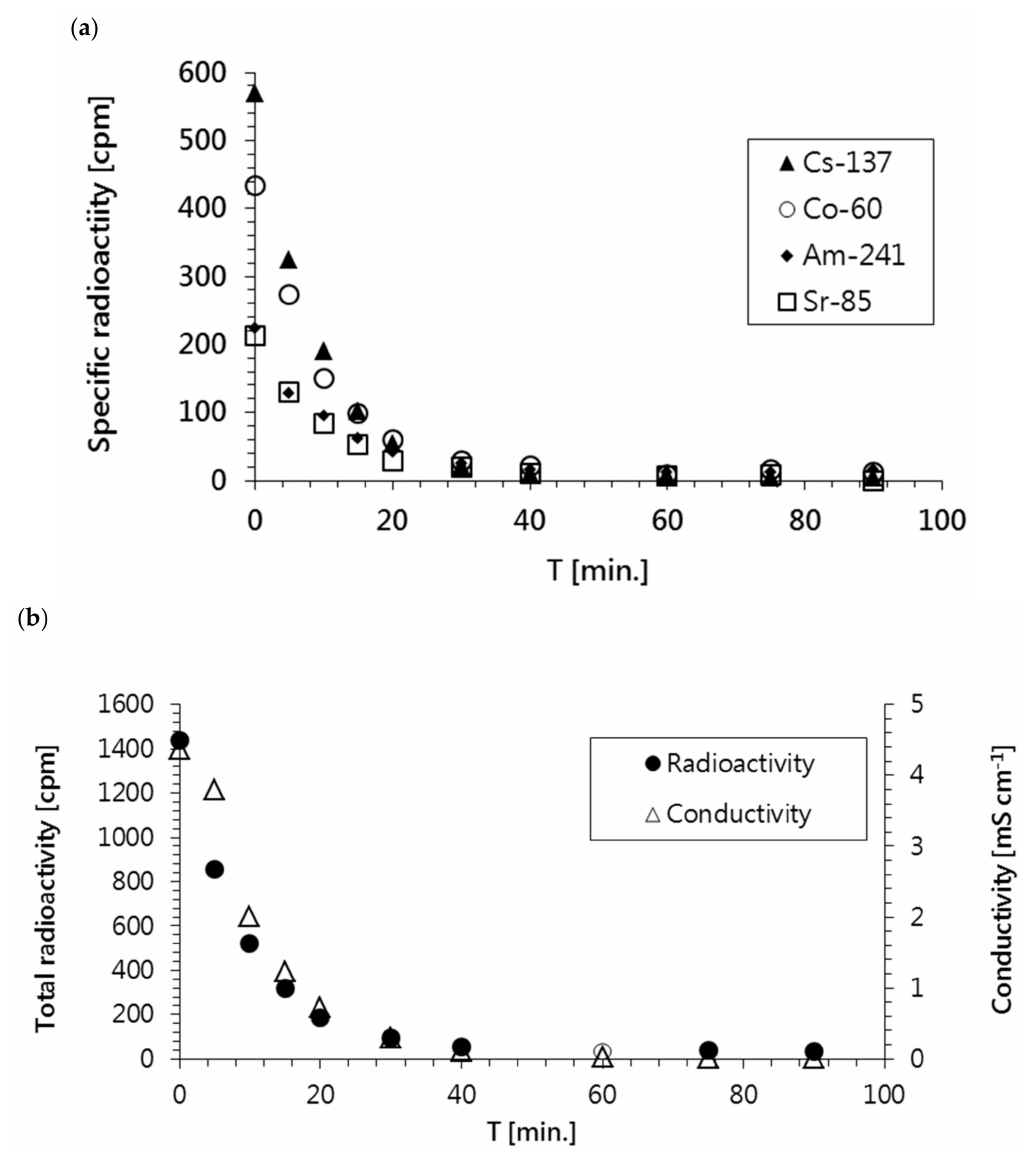
Figure 7. Changes in the radioactivity of the diluate stream during the electrodialysis of the real waste sample. ( a ) Radioac- tivities of main radioisotopes; ( b ) total